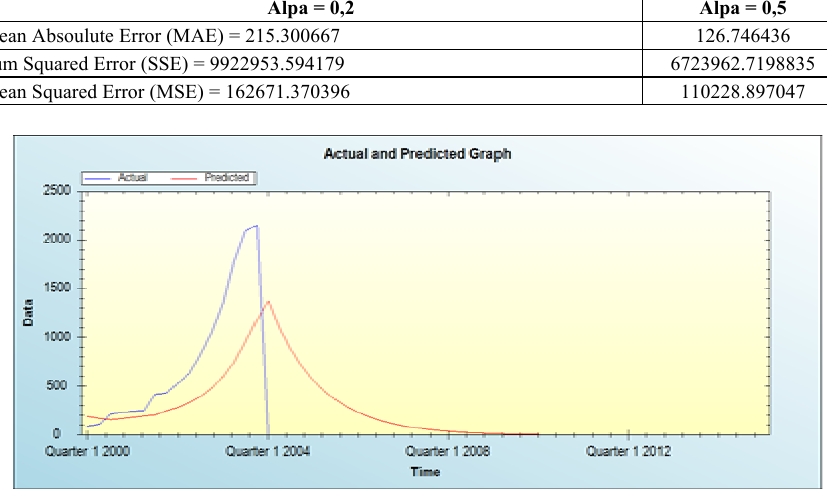
Fig 1 . Actual and Predicate Graph